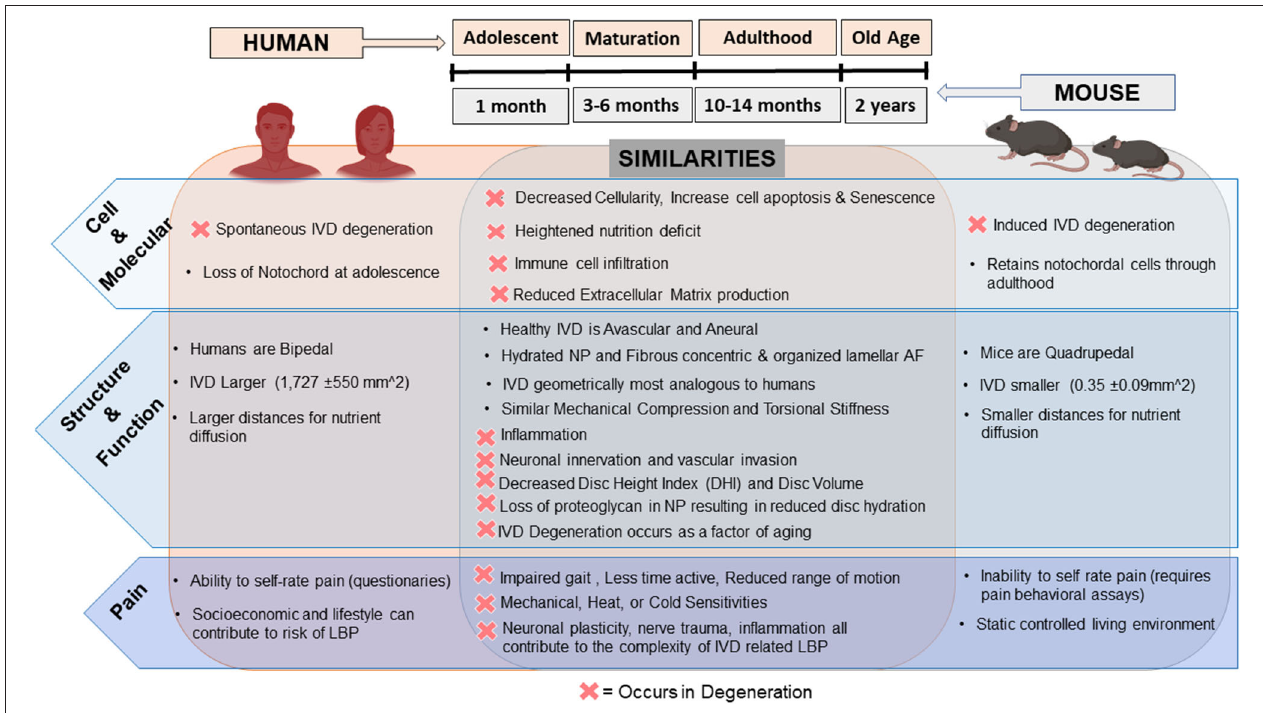
FIGURE 1 | Comparison of the human vs. mice intervertebral disc and changes in degeneration: humans are represented on the left along with mice on the right and their respective similarities in the healthy and degenerate/diseased IVD (D = occurrence in degeneration) overlapping in the middle. Top middle depicts relative timeline of mice age compared to humans. Depiction of human and mice in this figure generated using